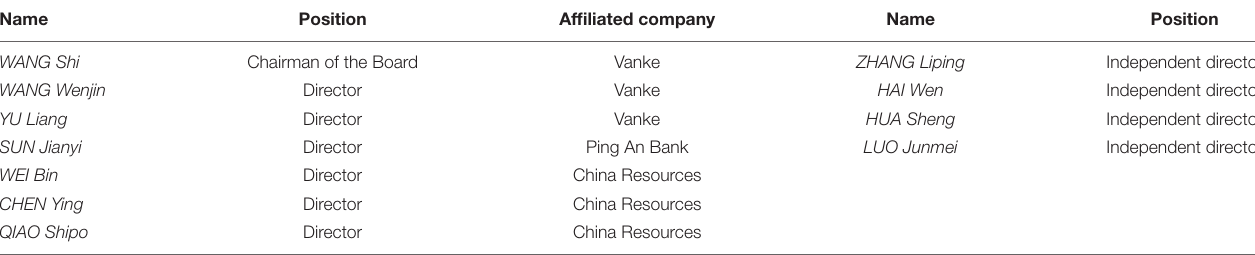
TABLE 7 | List of Vanke board of directors.